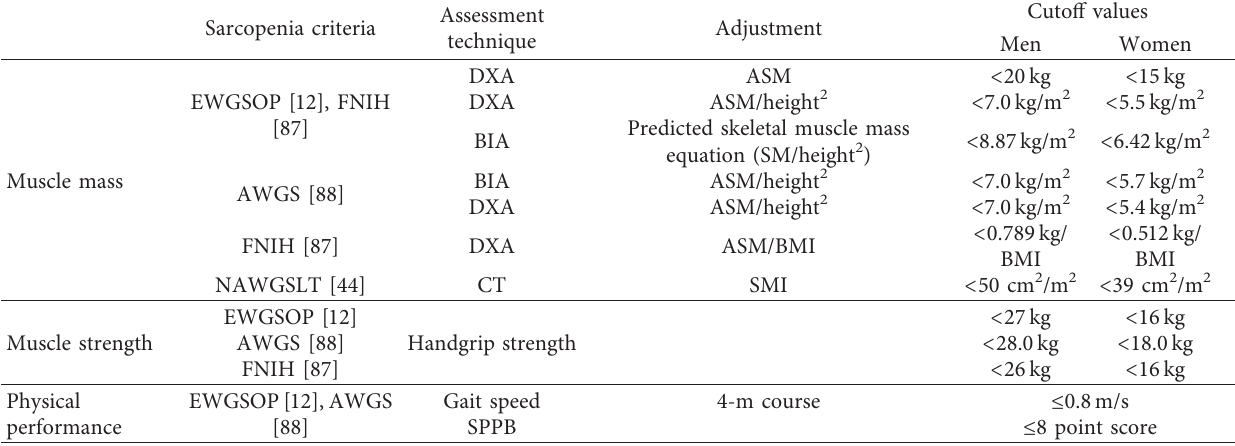
Table 1: Techniques and criteria for assessing muscle mass, muscle strength, and physical